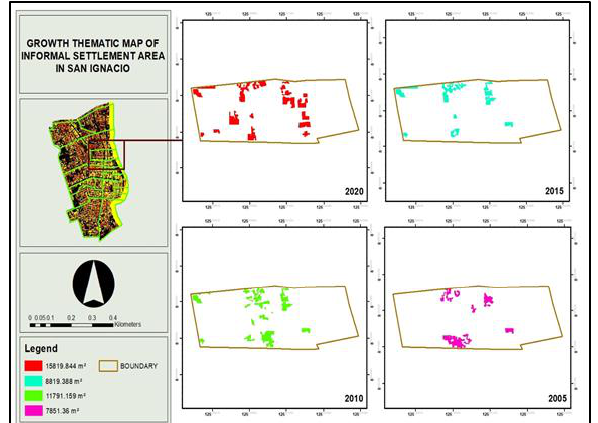
Figure 15. Thematic Map of Brgy. San Ignacio from